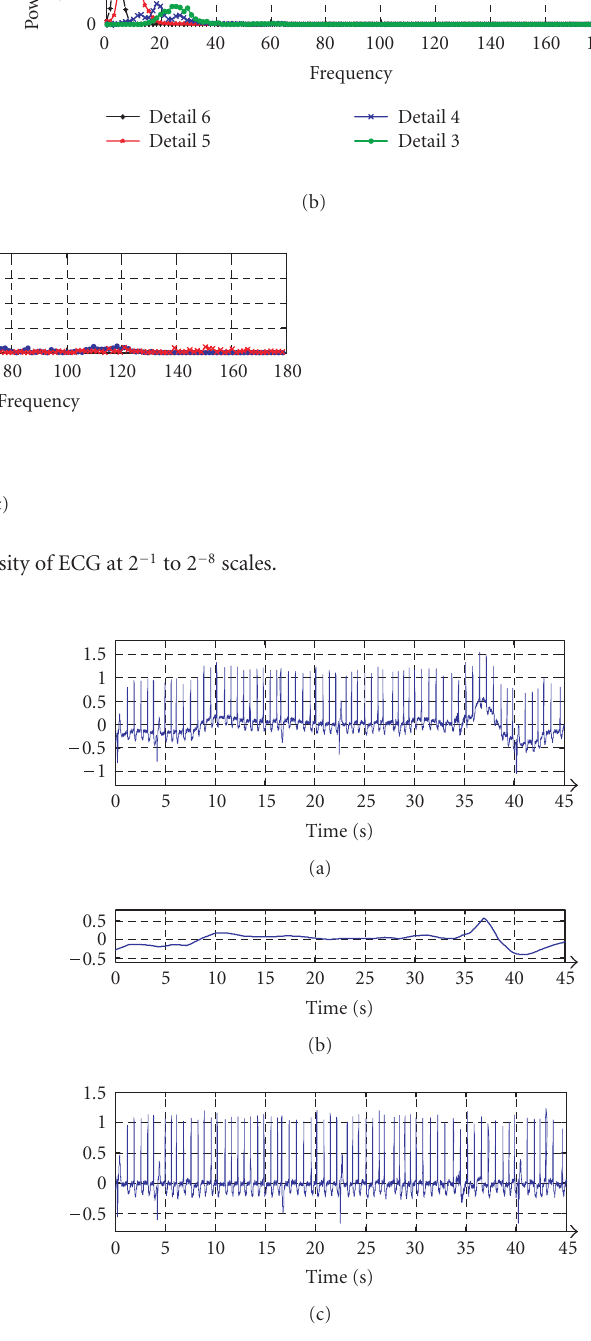
Figure 6: The ECG record “b108-2,” (a) original ECG signal, (b) estimated baseline drift, (c) ECG after removing the baseline.